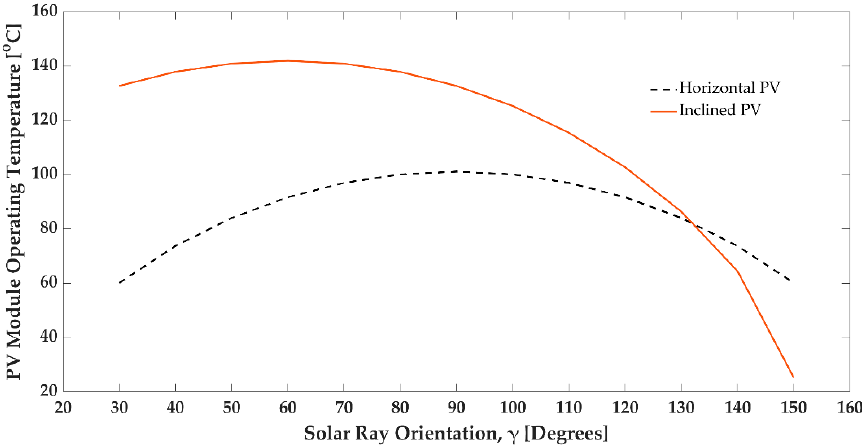
Figure 11. PV module operating temperature vs. solar ray orientation γ , horizontal PV module, and inclined PV module, η = 12% ; solar flux is constant at G t = 1000 W/m